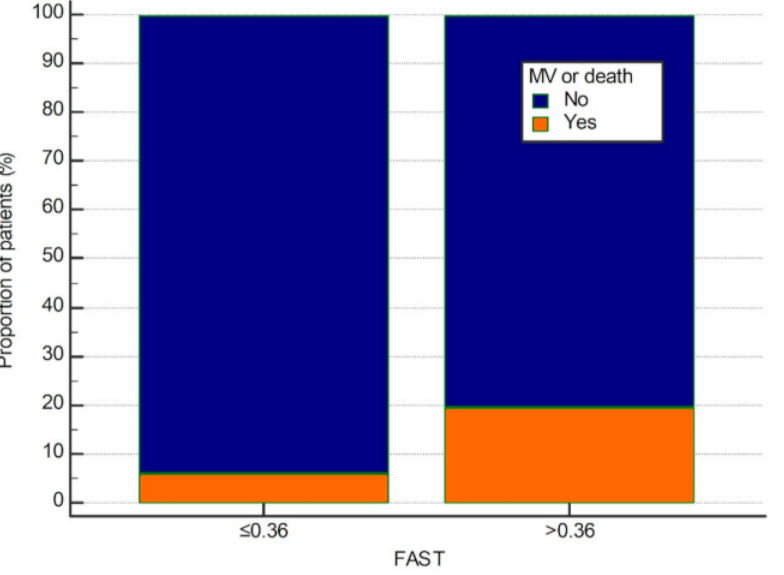
Figure 1. Thirty-day mechanical ventilation or death rates stratified according to the FAST > 0.36. MV, mechanical ventilation; FAST, FibroScan-AST